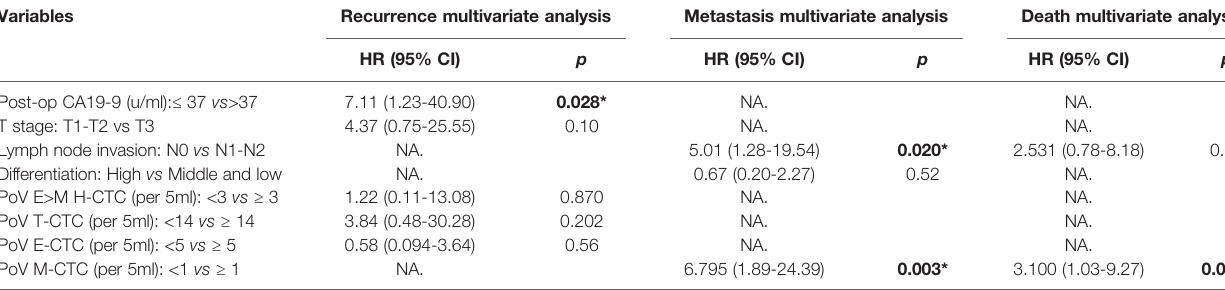
NA, no application. Bold values indicate that the results were statistically signi fi